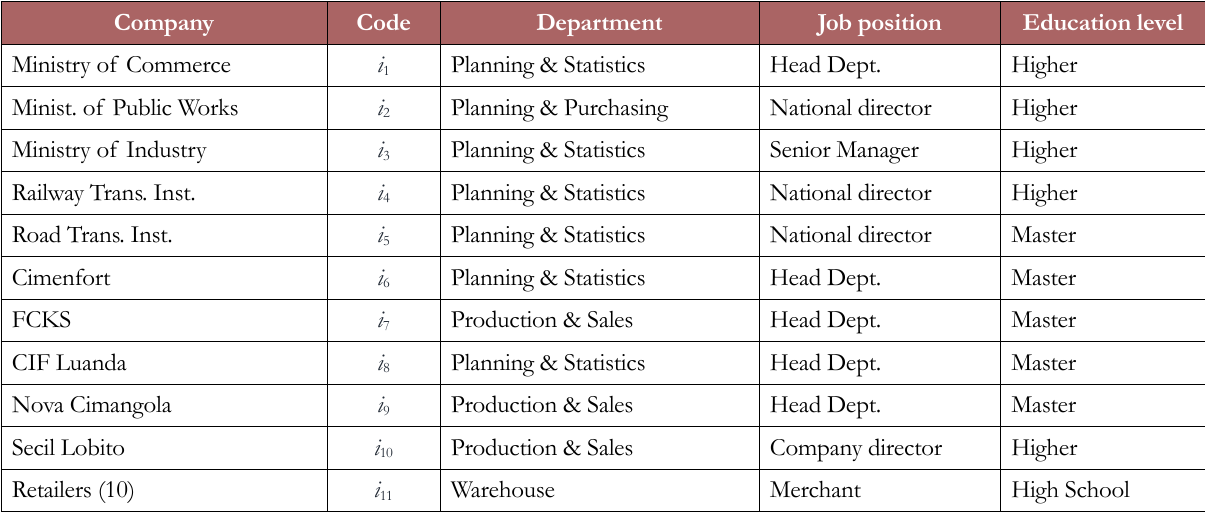
Table 3. Profiles of